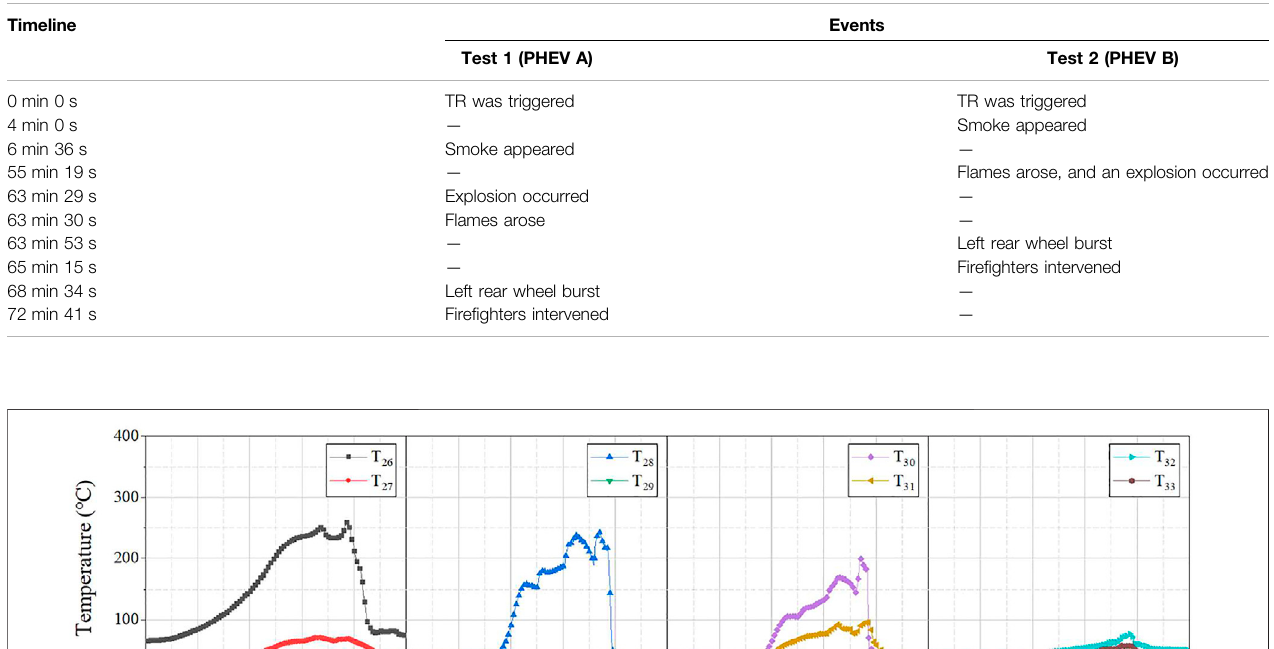
TABLE 3 | Timeline of the burning process.